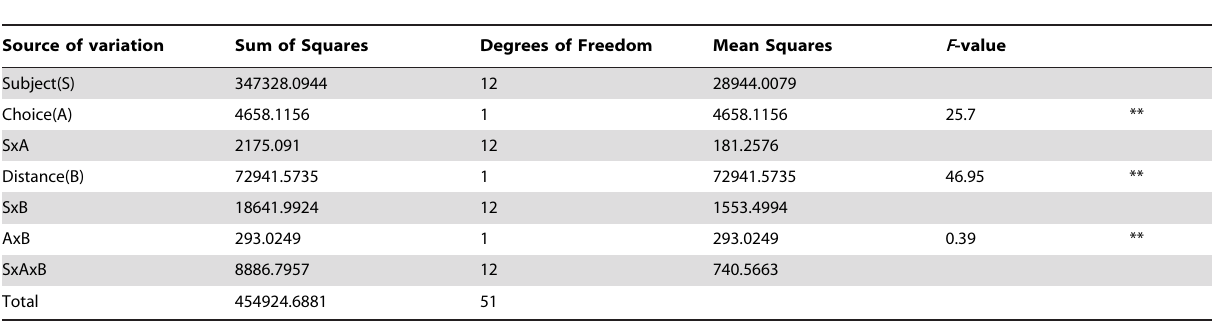
Table 1. ANOVA table of response time